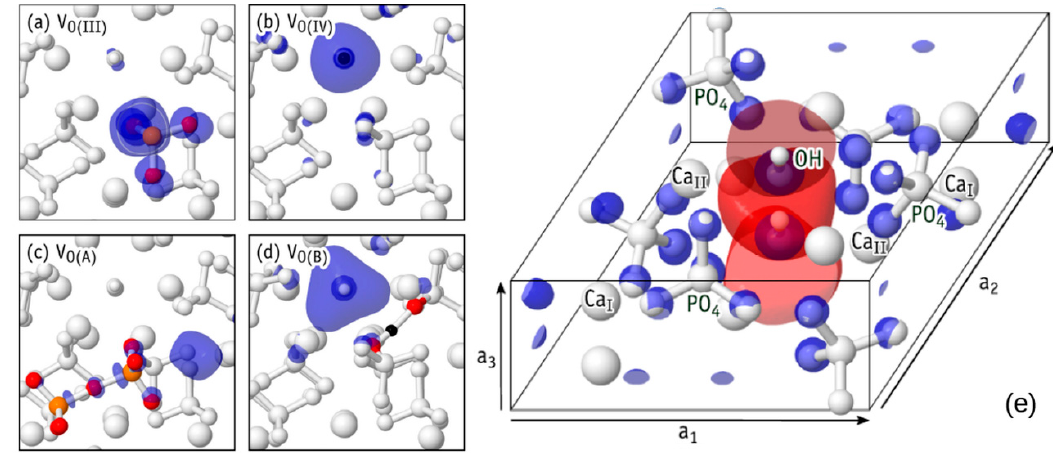
Figure 13. The electron density isosurfaces of the highest occupied Kohn − Sham electron level (for HAp neutral V O vacancy) for: ( a ) V O(III) (for V O(I) and V O(II) are the similar); ( b ) V O(IV) , where oxygen O(IV) atom leading to an insulated hydrogen atom in the HAp OH channel; ( c ) V O(A) (extended charged defect); and ( d ) V O(B) (extended charged defect). In all cases, the isosurfaces are shown for the constant level of the electron density n = 0.001 Å − 3 . Reprinted with permission from [35]. Copyright (2019) American Chemical Society. ( e ) The lowest unoccupied Kohn–Sham electron state (bottom of the conduction band) of a HAp at k = G. Blue isosurfaces represent y(r) = + 0.02 phases of the electron wave function and red ones represent y(r) = 0.02. All atoms are shown in white. Reprinted with permission from [34]. CCC (2018) AIP Publishing.